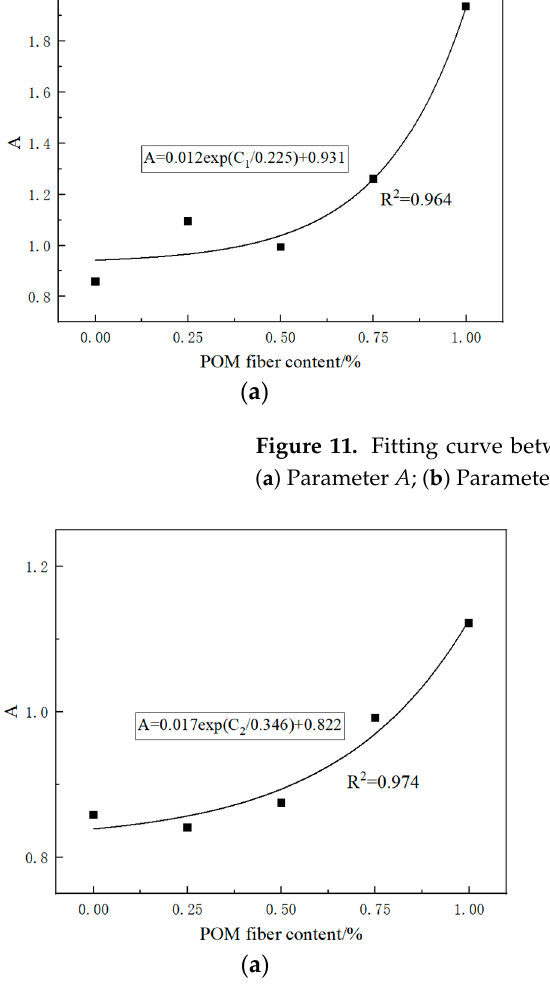
Figure 12. Fitting curve between volume content of 12 mm POM fiber and parameters A and B : ( a ) Parameter A ; ( b ) Parameter B .